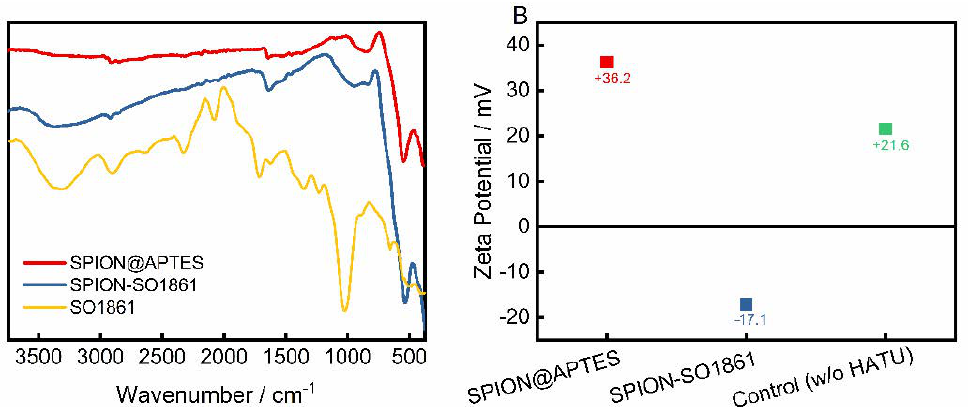
Figure 5. ( A ) FTIR-spectra and ( B ) zeta potential measurements before and after functionalization with SO1861. In the control experiment SPION@APTES and SO1861 were mixed together without the addition of